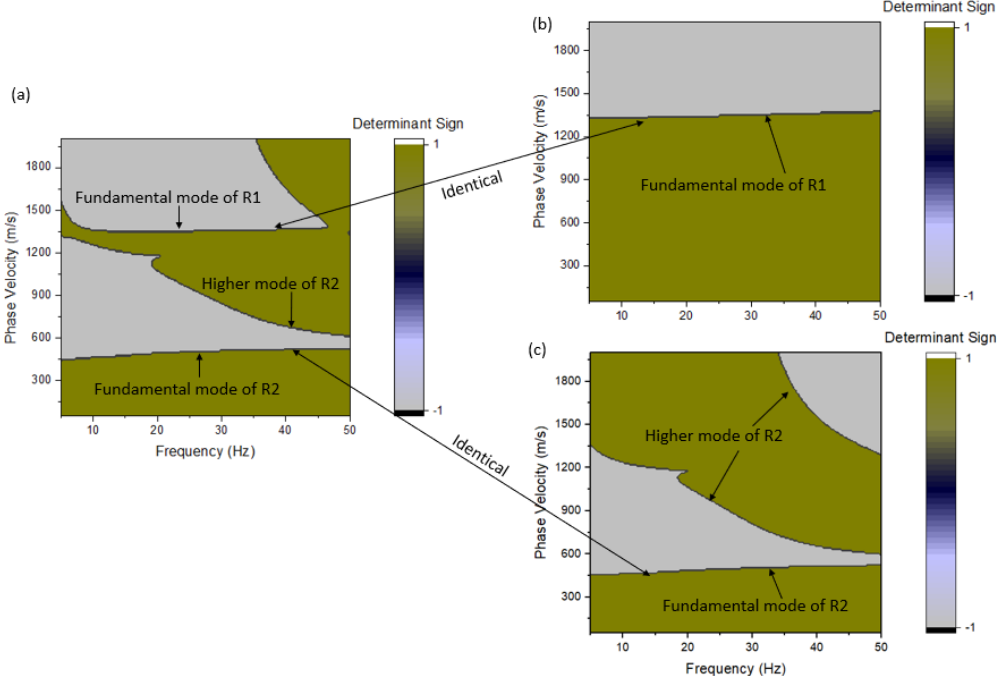
Figure E1. Decomposition of the global stiffness matrix. (a) Dispersion image (a combination of R1 and R2 waves). (b) Dispersion image using the components related only to the P1 and S1 wave velocities. (c) Dispersion image using the components related only to the P2 and S2 wave